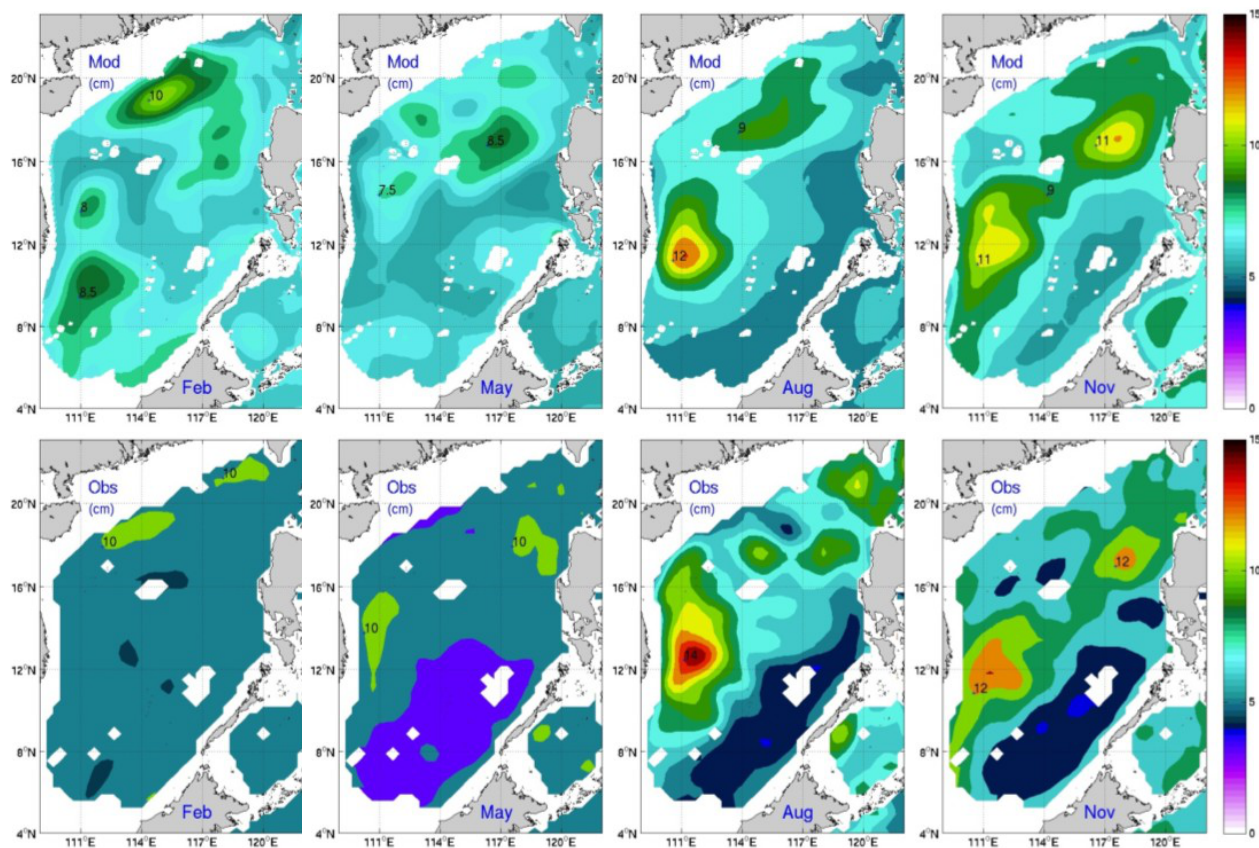
Fig. 5. The upper panel is the standard deviation of SLA present in our model “running” seasonal ensemble for the different assimilation times (at the first day of the month for February, May, August, and November, respectively). The bottom panel shows the corresponding variability computed using observed SLA maps for the period 2002 to 2007. The regions in water shallower than 200m are